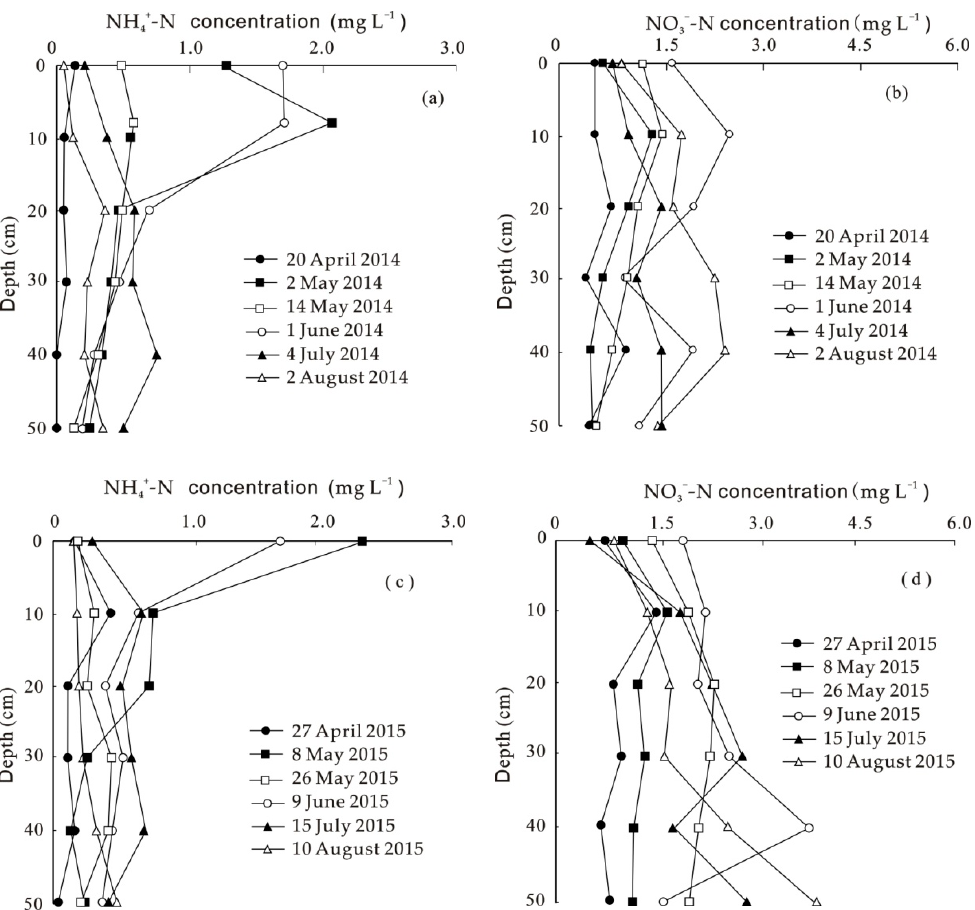
Figure 4. Concentrations of ( a ) NH 4+ -N and ( b ) NO 3 − -N measured in the vertical soil profile during the experimental periods in 2014 and concentrations of ( c ) NH 4+ -N and ( d ) NO 3 − -N measured at various depths during the experimental periods in 2015.